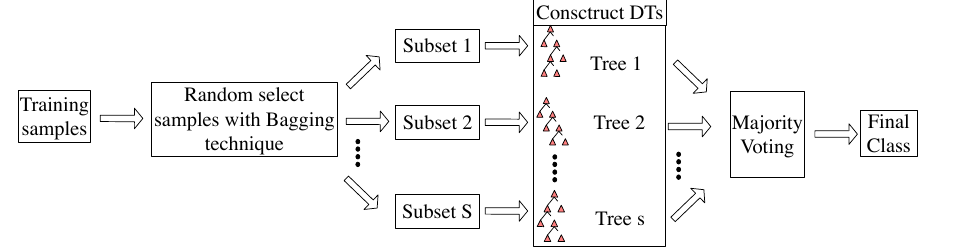
Figure 3. Steps for building a random